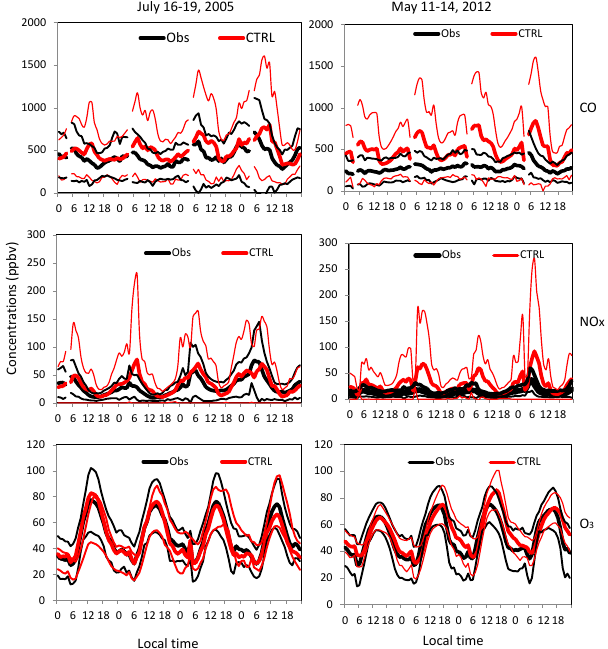
Figure 3. The comparisons of CO, NO x , and O 3 concentrations be- tween observations (bold black) and simulations (bold red) in Do- main 4. There are 23 sites for NO x , 20 sites for CO, and 65 sites for O 3 observations during the study time periods. The locations are shown in Fig. 1b. The variation ranges of simulation and obser- vation are correspondingly labeled by thin-red-line and thin-black- line, respectively. Missing observation time (04:00 local time) is masked in the figure. CTRL represents WRF-Chem control